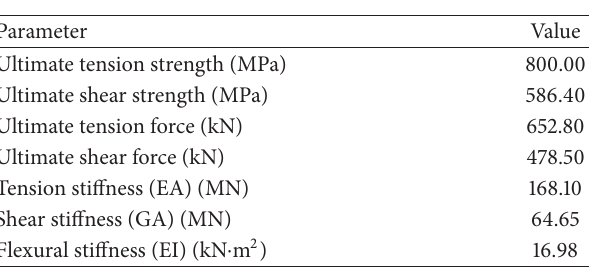
Table 3: Mechanical properties for joint bolts.